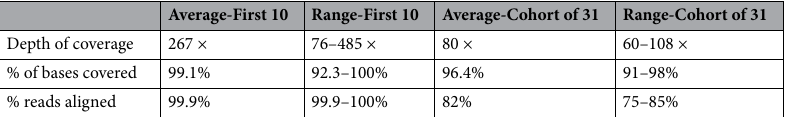
Table 2. Summary of Metrics across both